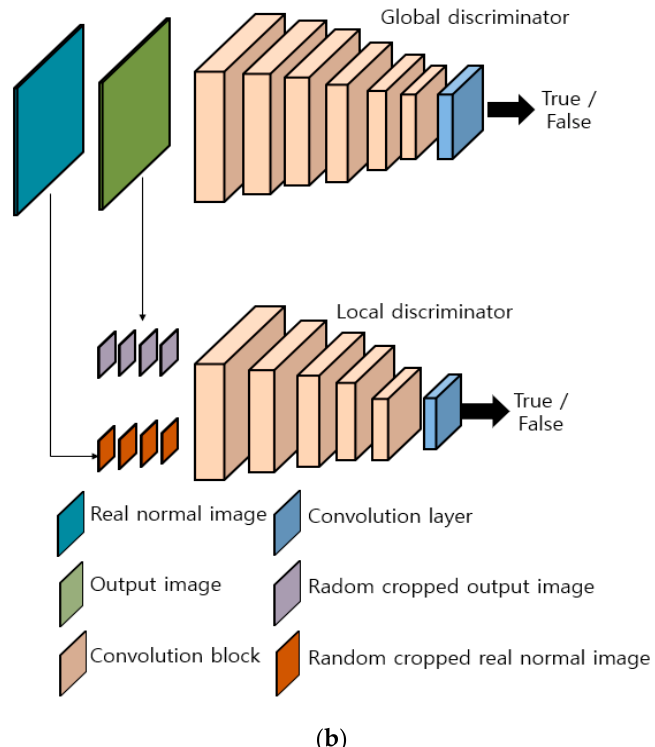
Figure 2. Architecture of modified EnlightenGAN: ( a ) generator and ( b ) discriminator.